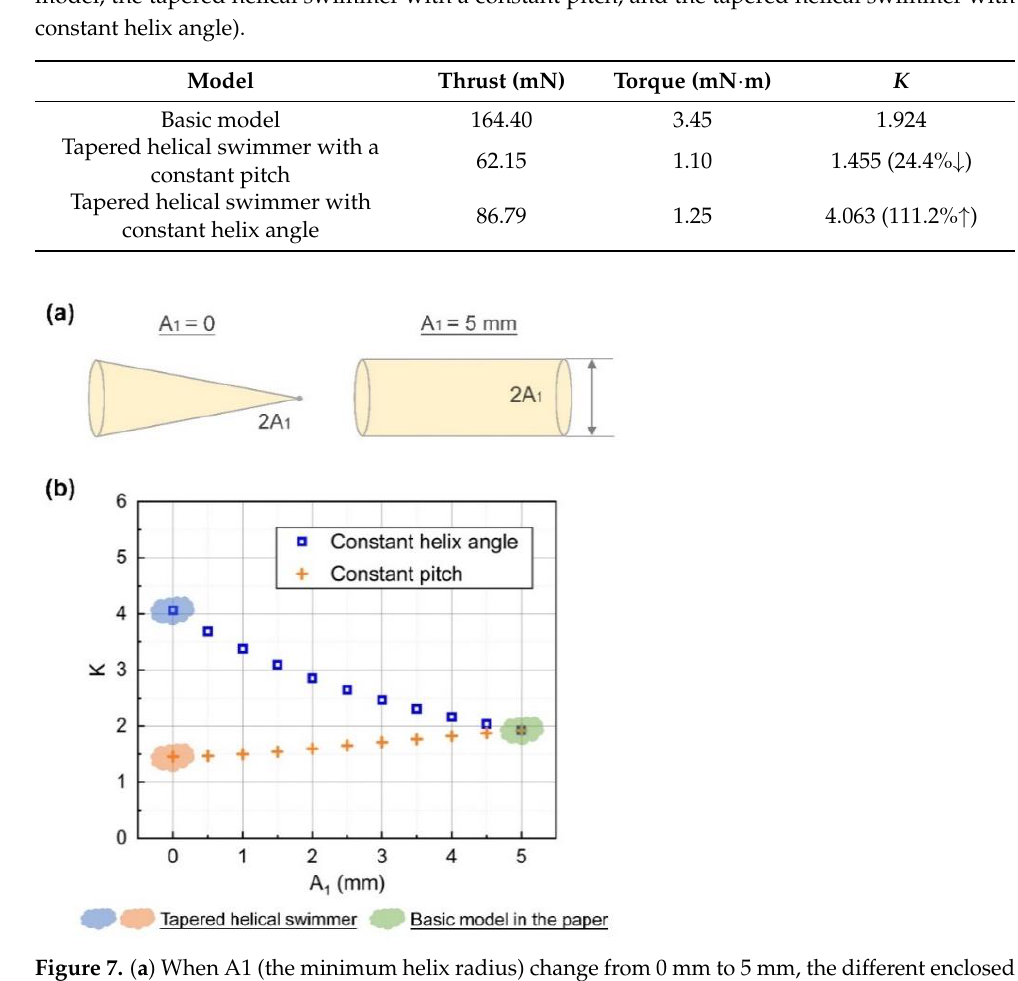
Figure 7. ( a ) When A1 (the minimum helix radius) change from 0 mm to 5 mm, the different enclosed volume is shown. ( b ) Changes in the evaluation index from the basic model to the tapered structures. When A 1 = 0, it is the tapered structure. The blue mark represents the structure with a constant helix angle, the orange mark represents the structure with a constant pitch, and the orange mark represents the basic model.